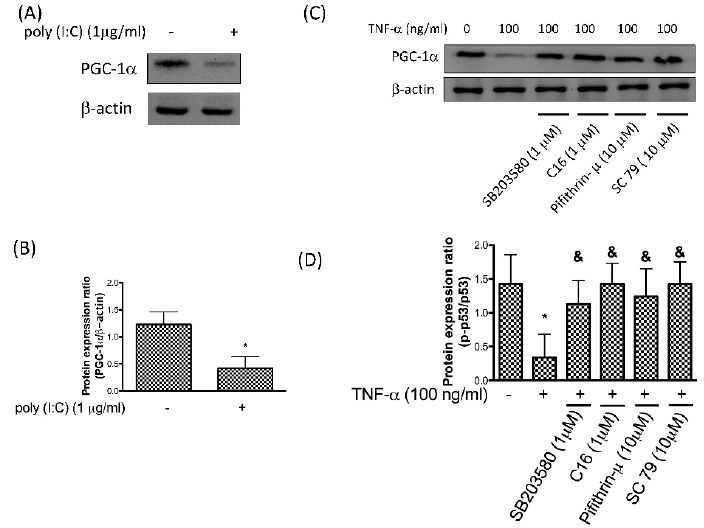
Figure 4. Protein expression ( A ) and ratio ( B ) of PGC-1 α after activation of PKR using poly (I:C); protein expression ( C ) and ratio ( D ) of PGC-1 α after TNF- α treatment in human chondrocytes in the presence or absence of p38 inhibitor SB203580, PKR inhibitor C16, p53 inhibitor Pifithrin- µ or AKT activator SC79 ( n = 3; * p < 0.05 compared to control group. p < 0.05 compared to TNF- α group, p values were generated by ANOVA using the Tukey’s test).